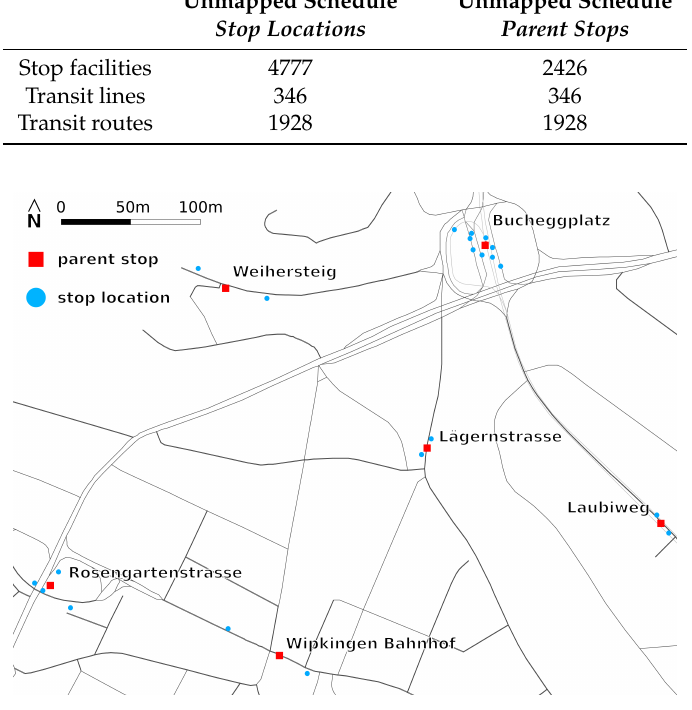
Figure 6. Example for the stop locations and parent stops available in the GTFS feed for the Zurich area.